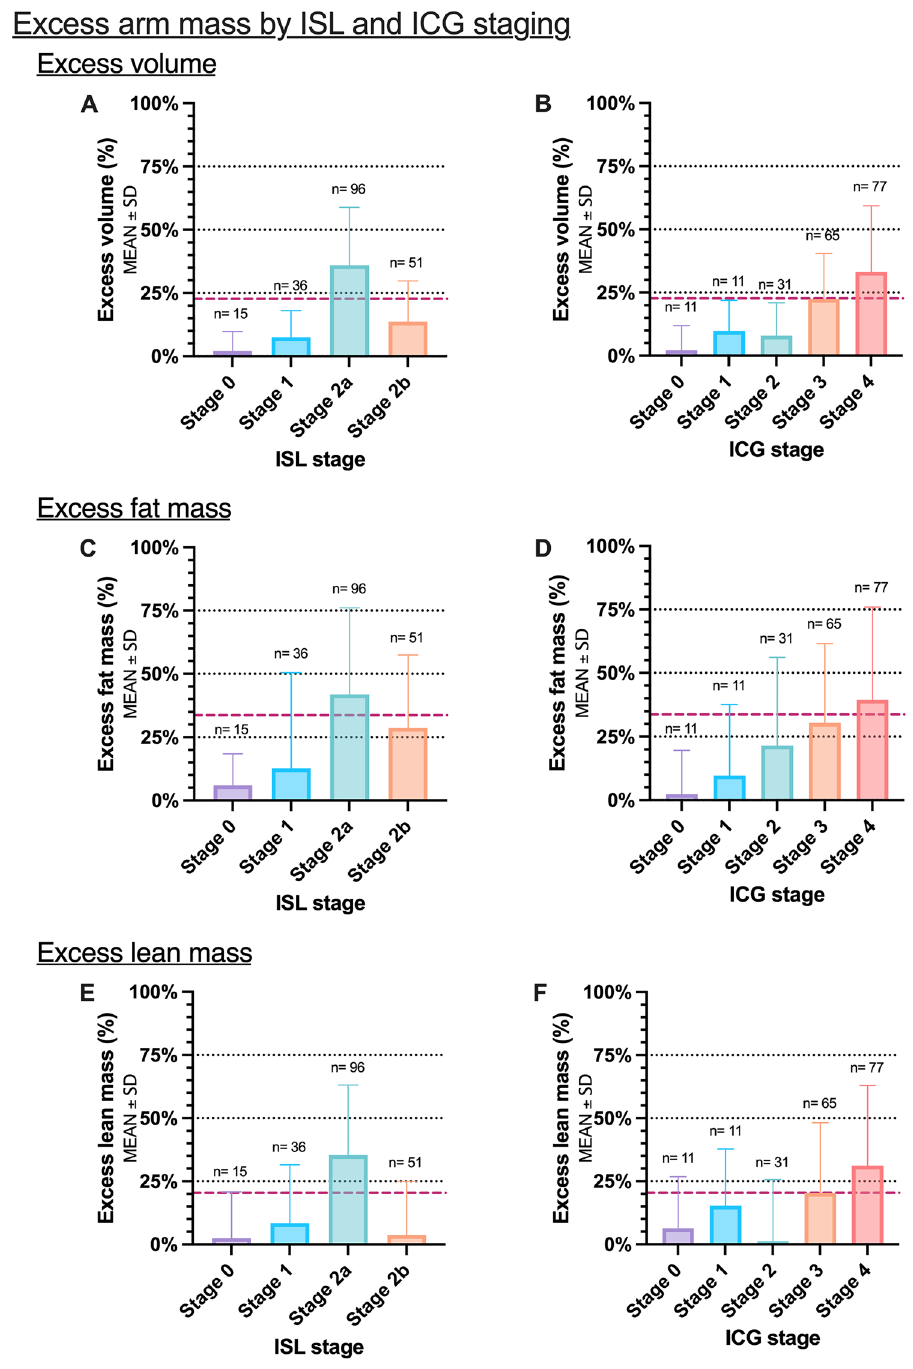
Figure 2. This figure shows the distribution of excess arm volume, fat and lean mass in lymphedema patients stratified by clinical ISL and lymphangiography staging. ( A ) Excess volume and ISL stage. ( B ) Excess volume and ICG stages. ( C ) Excess fat mass and ISL stage ( D ) Excess fat ass and ICG stages. ( E ) Excess lean mass and ISL stage ( F ) Excess lean mass and ICG stages. Black horizontal dotted lines denote 25%, 50%, and 75%. The red striped line denotes the mean excess volume, fat and lean mass for the study. * P -value < 0.05. ** P -value <